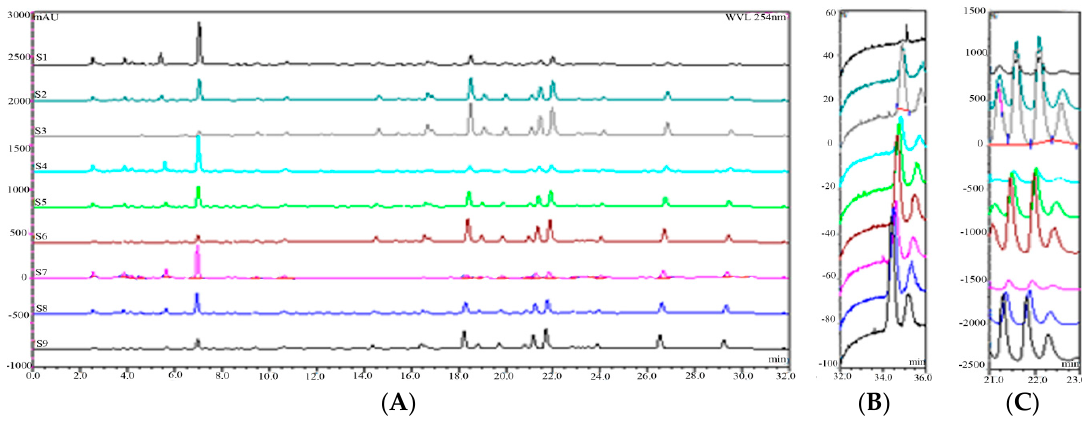
Figure 4. The HPLC fingerprints of nine GBE samples with UV ( A ) and ELSD ( B , C ).